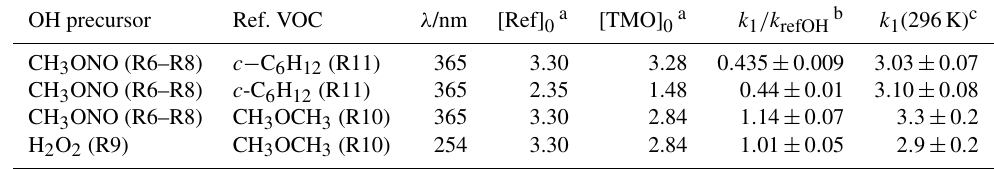
Table 3. Results from relative rate experiments to determine k 1 (296K) for OH + TMO from this work. OH precursor